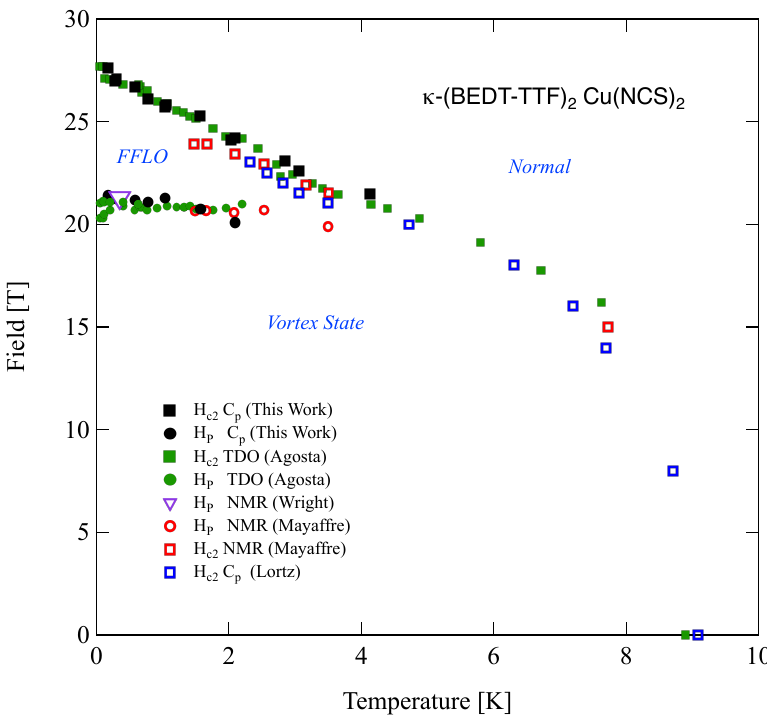
Figure 4. Color online. From Agosta et al. [3] Phase diagram of κ ET-CuNCS for parallel magnetic field ( θ = 0). Solid black circles represent calorimetric observations of the phase transitions between the lower and higher field superconducting phases at H P , and squares, the normal and superconducting state at H c 2 ( T ) . Points from an earlier calorimetric determination of H c 2 ( T ) [93] are shown as open blue squares. Also included are determinations of both the H c 2 and H p phase boundaries by means of rf penetration measurements (green) [6] and NMR measurements [7,8] (open purple and red symbols,